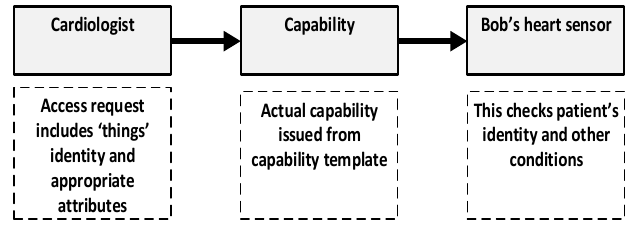
Figure 5. Usinga capabilityforaccessing a